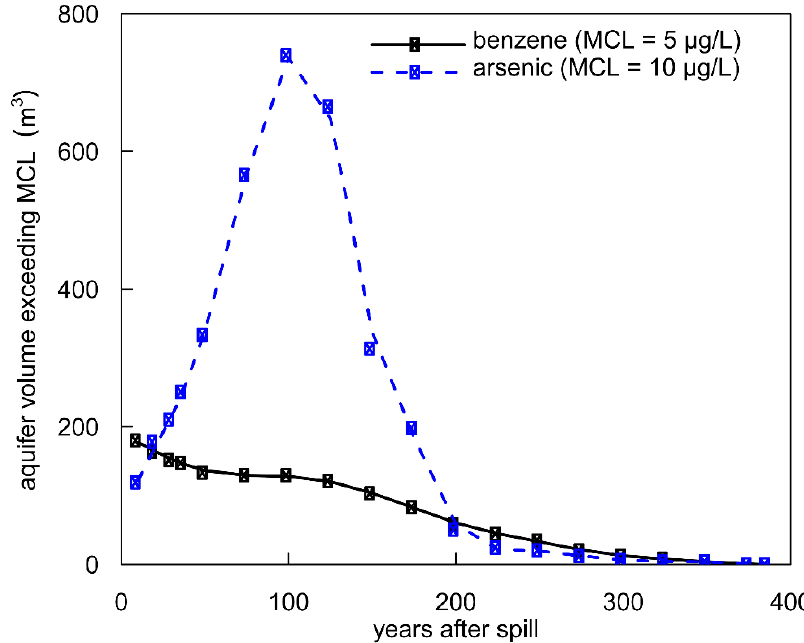
Figure 10. Model simulations for the total aquifer volume, assuming 1 m aquifer thickness, exceeding the maximum contaminant level for benzene (5 µg/L; black) and arsenic (10 µg/L; blue) over time.